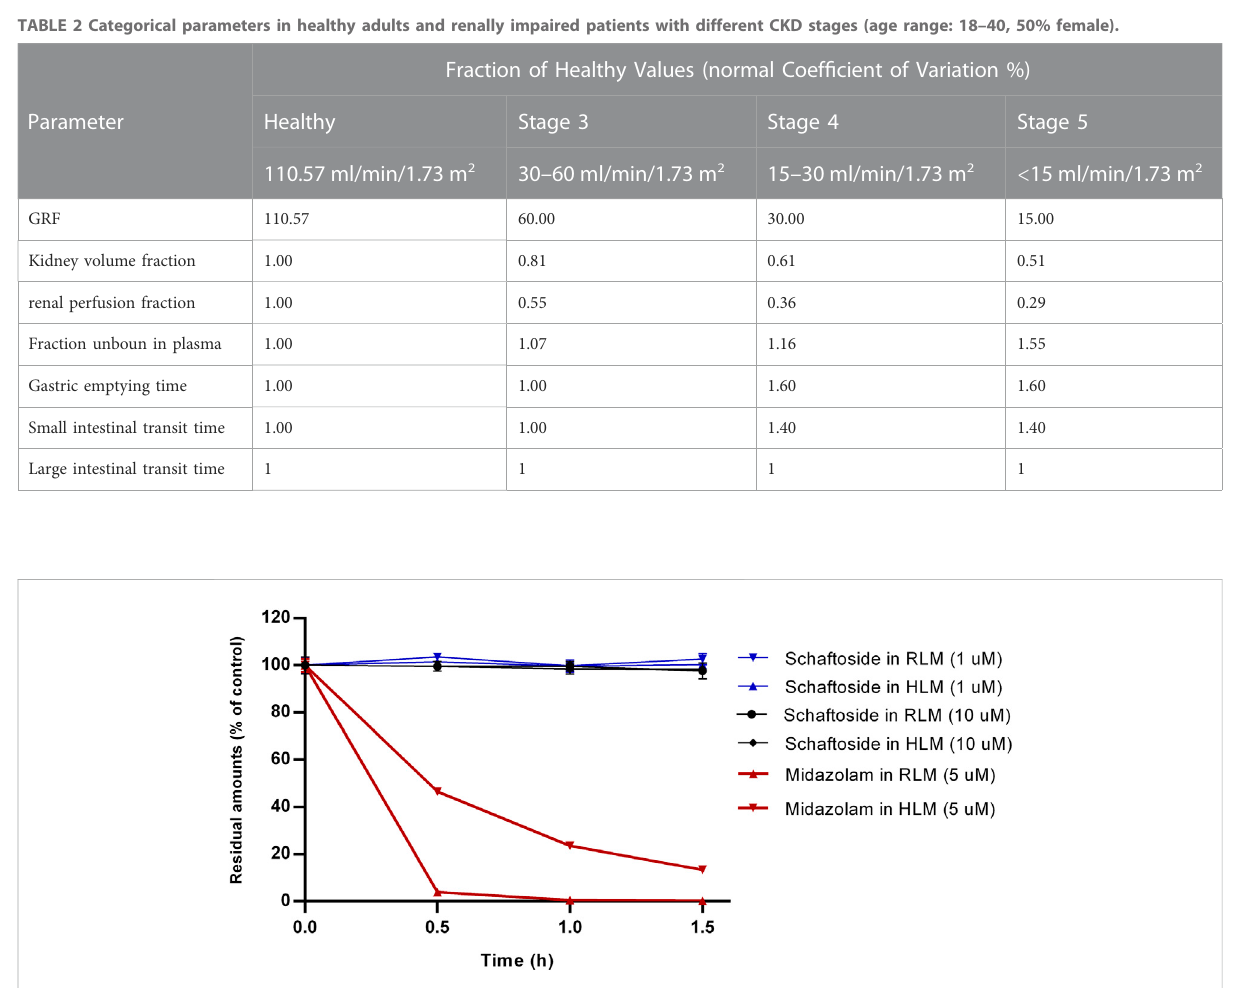
FIGURE 2 In vitro metabolism of schaftoside in rat liver microsomes (RLM) and human liver microsomes (HLM). Midazolam, a representative substrate of CYP3A4/5 enzyme in liver microsomes, was used a positive control of this